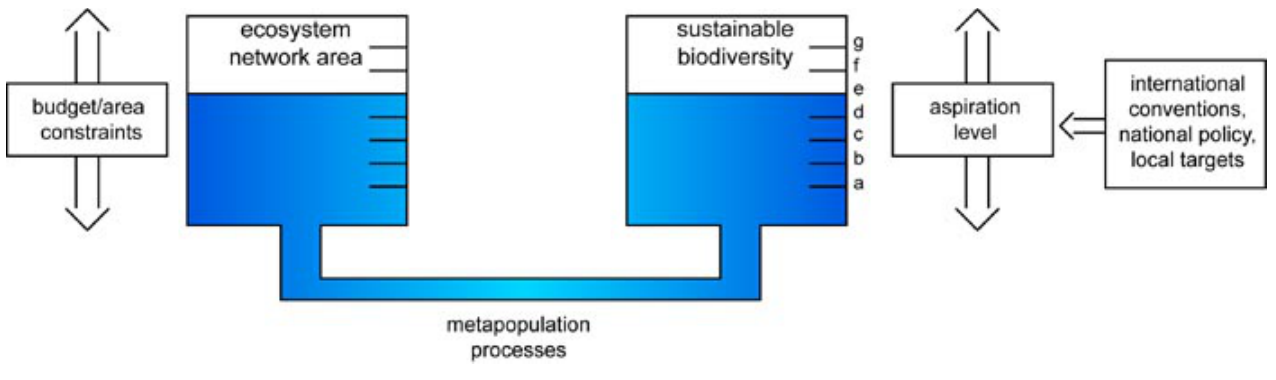
Fig. 1. Communicating vessels as a metaphor for the functional link between the aspiration level of biodiversity goal setting, and the required physical conditions in the landscape. The vertical arrows represent the context of the planning process, in which actors with opposing interests negotiate the desired level of biodiversity (considering national biodiversity policy goals) and the allocation and spatial combination of land-use